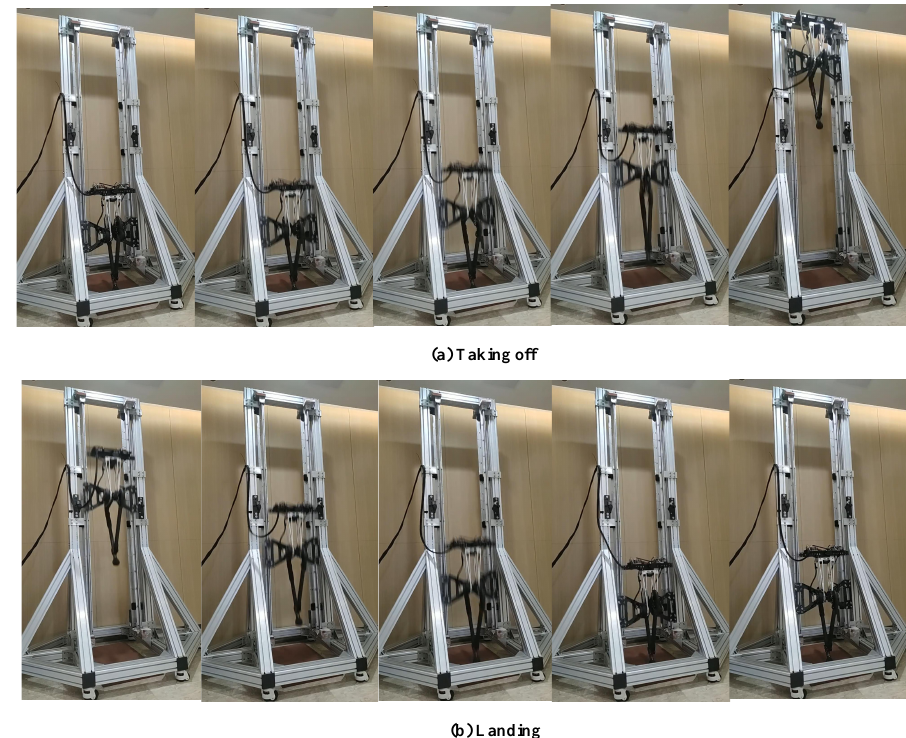
Figure 13. Snapshots of vertical jumping experiments.